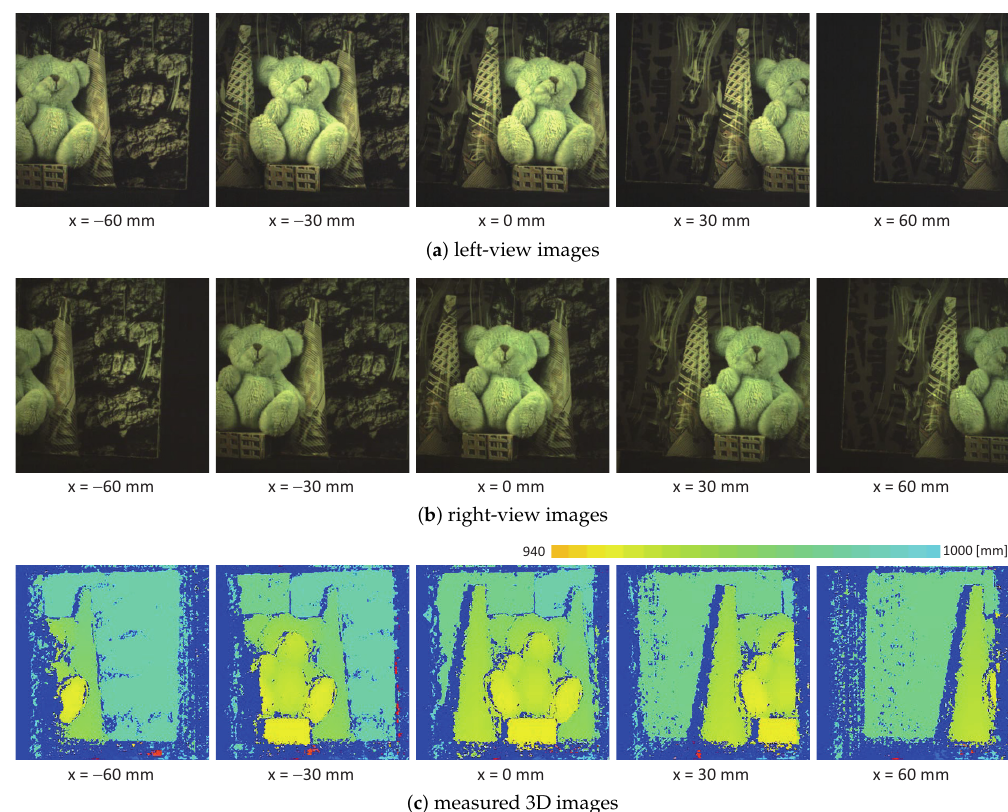
Figure 13. Measured 3D images for stationary 3D scenes at different x -coordinates when the mirror angles of the virtual left and right pan-tilt cameras were fixed without tracking: ( a ) left-view images; ( b ) right-view images; ( c ) measured 3D